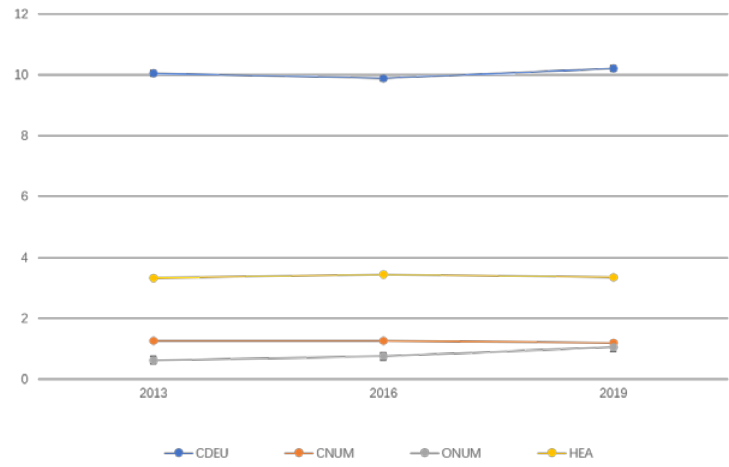
Figure 3. Three-year changes in dependent variables.